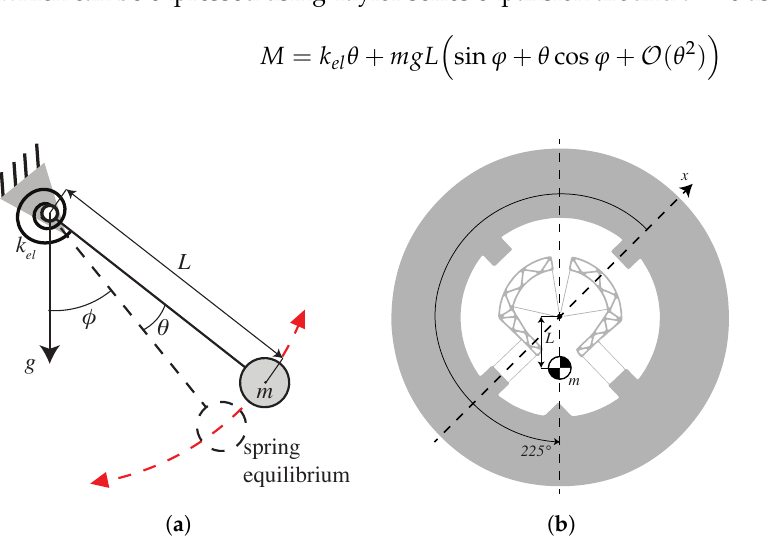
Figure 5. ( a ) Gravitational elasticity resulting from the addition of a pendulum to a rotational spring of stiffness k el and ( b ) practical implementation to compensate in-plane gravity effects on the co-RCC